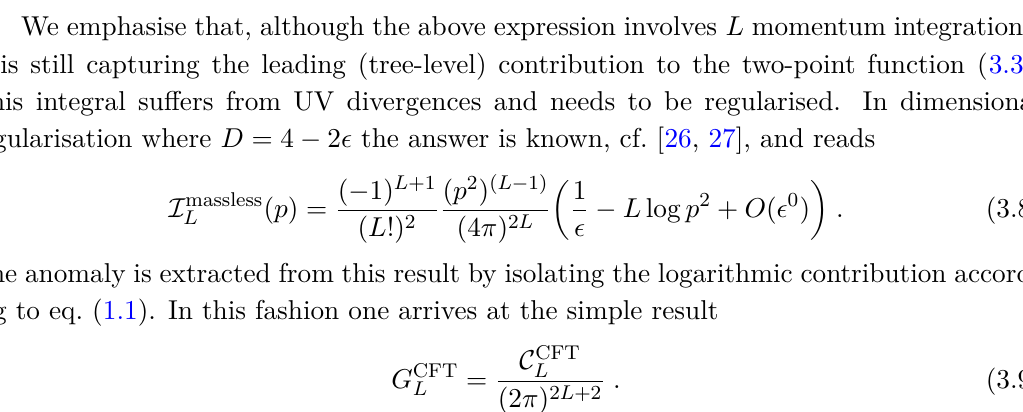
Figure 1 . The diagram determining the leading contribution to the two-point function